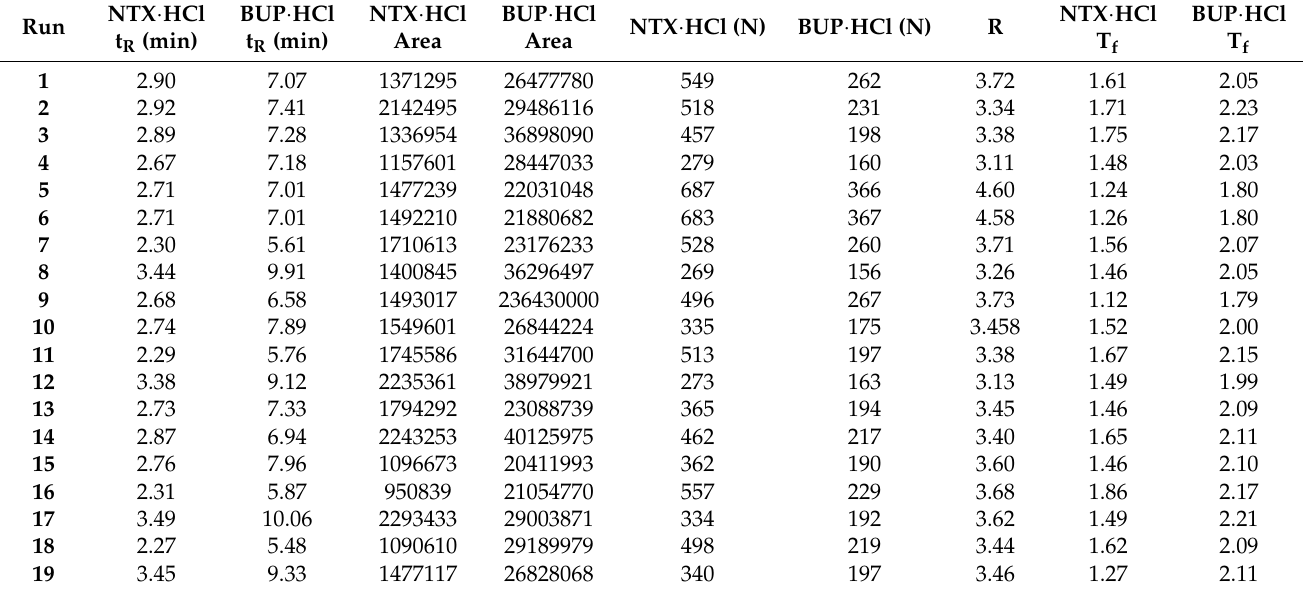
Table 7. Data of the responses obtained from the experiments of the experimental design.